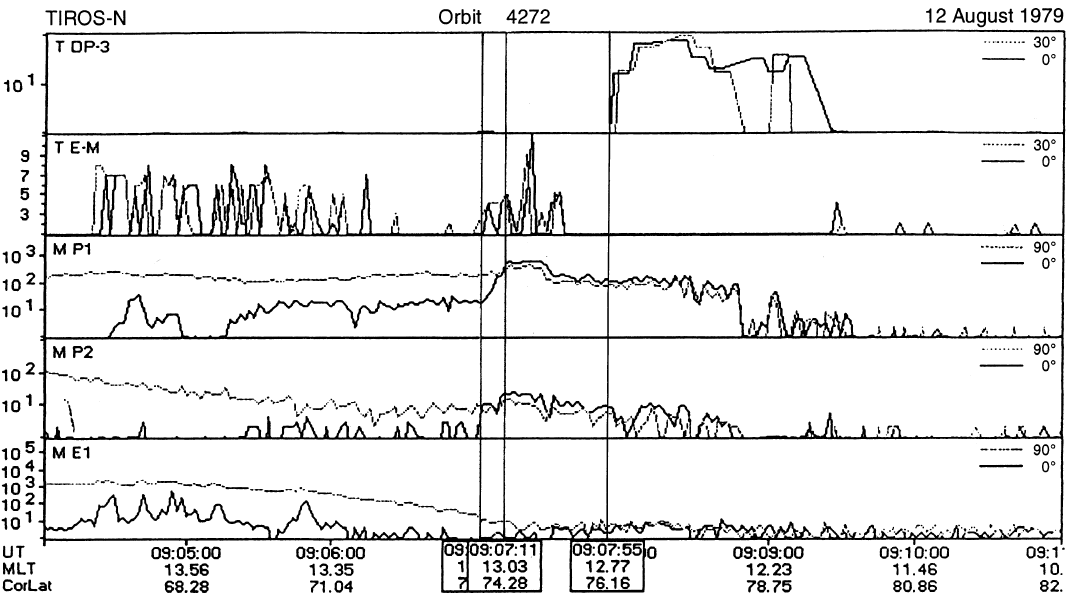
Fig. 7. Same as Fig. 6c,d but for nearly meridional crossing of TIROS spacecraft across the near noon dayside oval